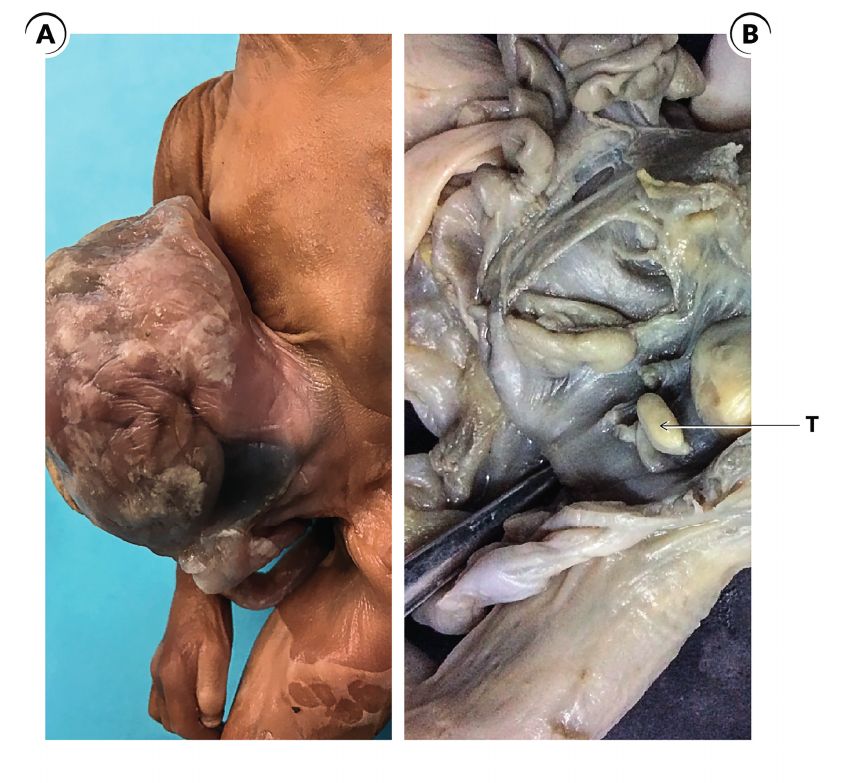
Figure 5 - Abdominal wall defects (AWDs) cases. A) The fi gure shows a male fetus with 24WPC and omphalocele; and B) In a fetus with 22WPC and omphalocele we can observe the testis (T) situated in the abdominal